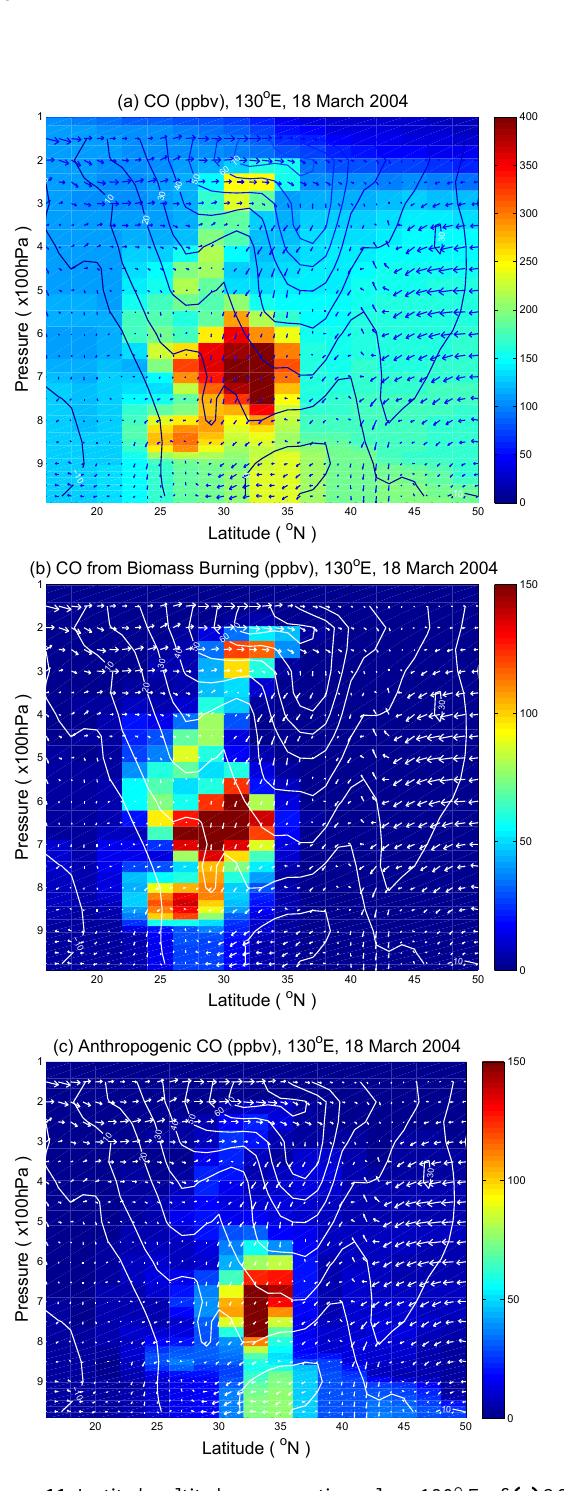
Figure 11. Latitude–altitude cross sections along 130 ◦ E of (a) CO, (b) CO from biomass burning, and (c) anthropogenic CO on 18 March 2004 at 00:00 UTC, simulated by GEOS-Chem. The contour lines indicate U wind speed (ms − 1 ) . Vectors are for wind directions in V and W . For a better illustration, W is enlarged by a factor of 100.